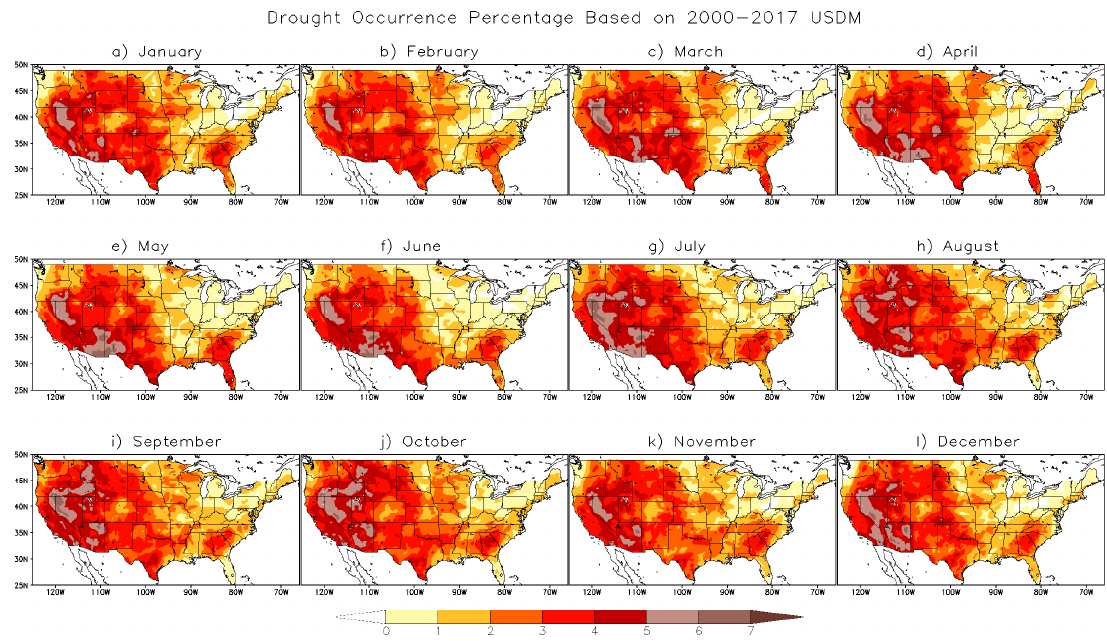
Figure 1. Maps of drought occurrence frequency (in percentage) based on rasterized 2000–2017 U.S. Drought Monitor (USDM) data for ( a ) January, ( b ) February, ( c ) March, ( d ) April, ( e ) May, ( f ) June, ( g ) July, ( h ) August, ( i ) September, ( j ) October, ( k ) November, and ( l ) December.